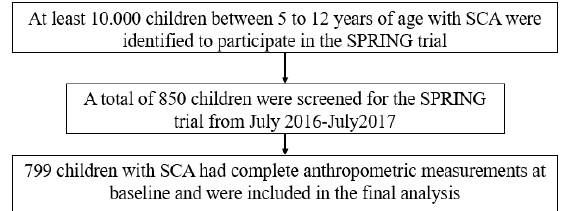
Figure 1. Participant recruitment flow diagram including children with sickle cell anemia screened for Primary Stroke Prevention in Nigeria (SPRING) trial.